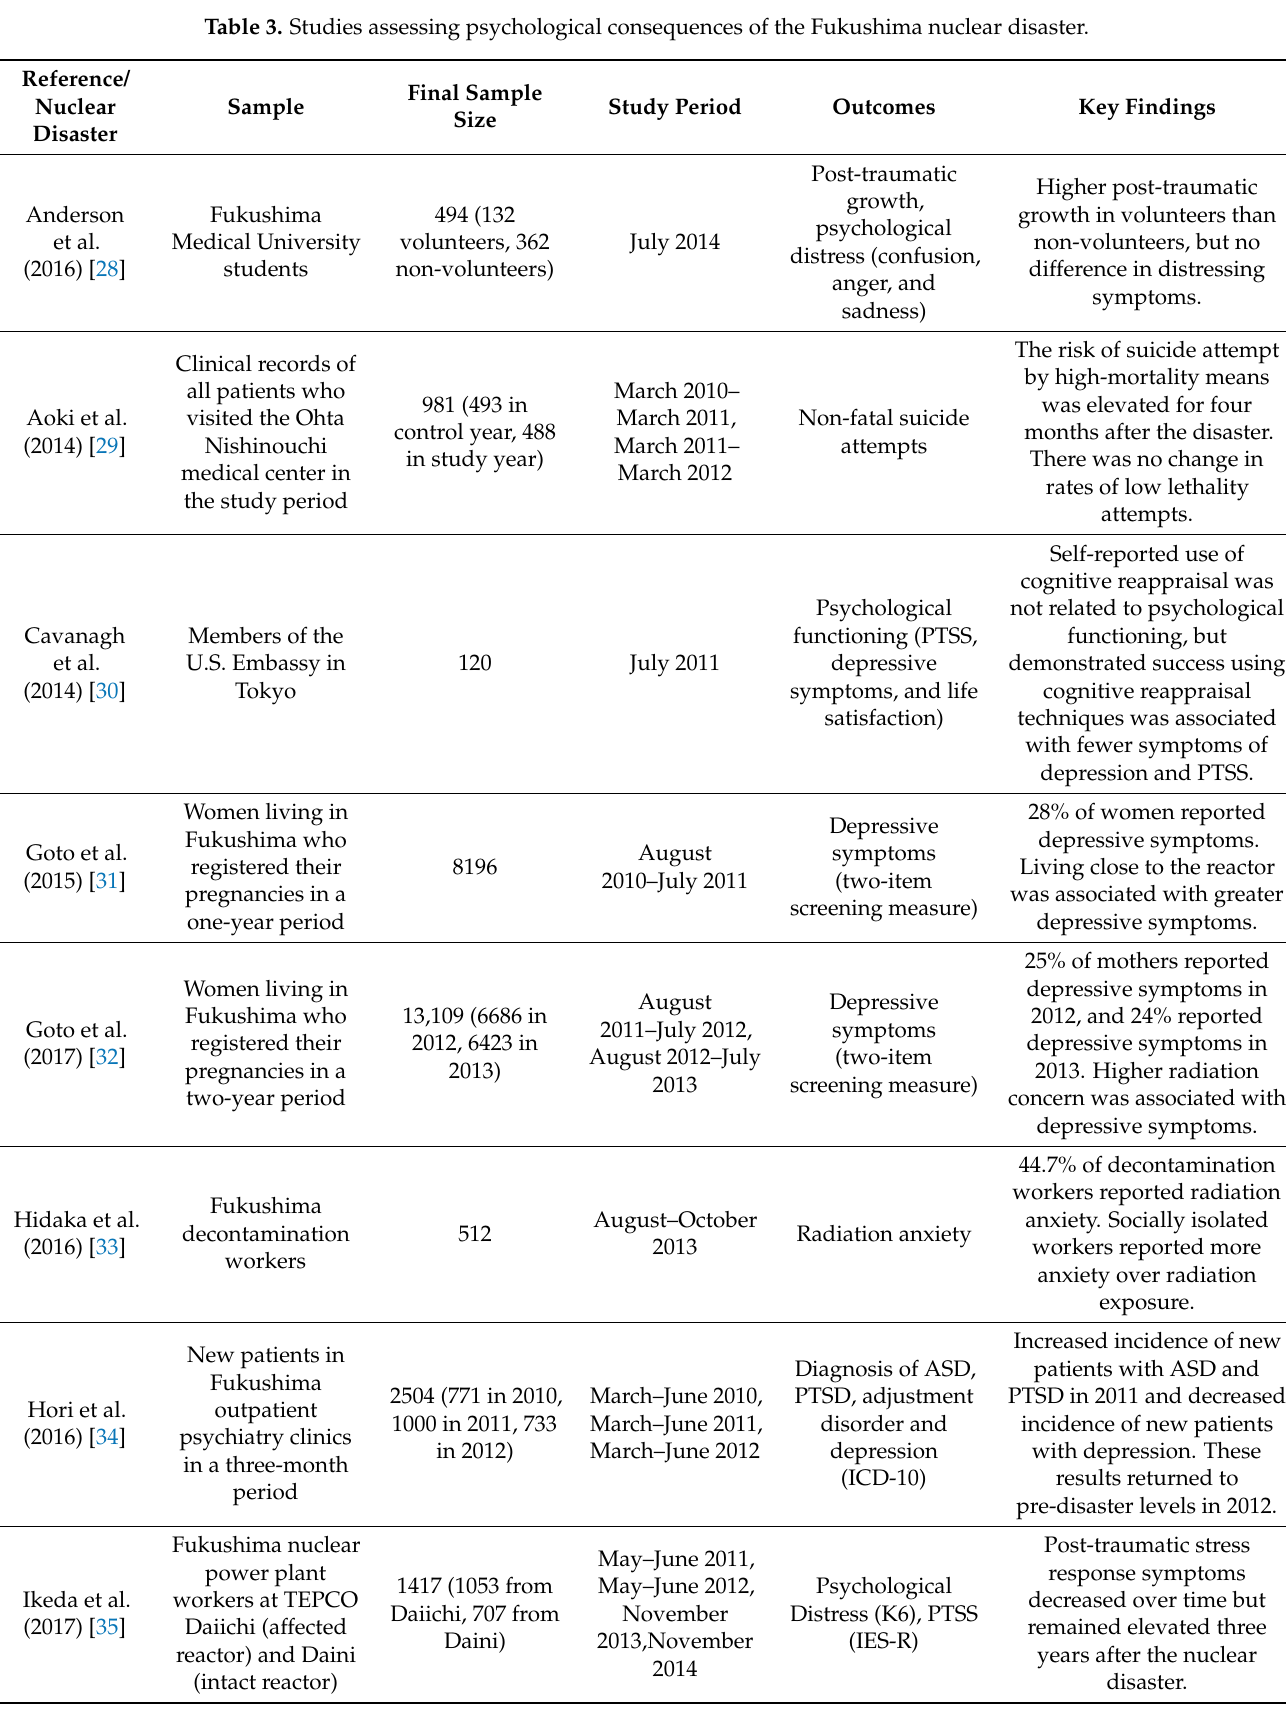
Table 3. Studies assessing psychological consequences of the Fukushima nuclear